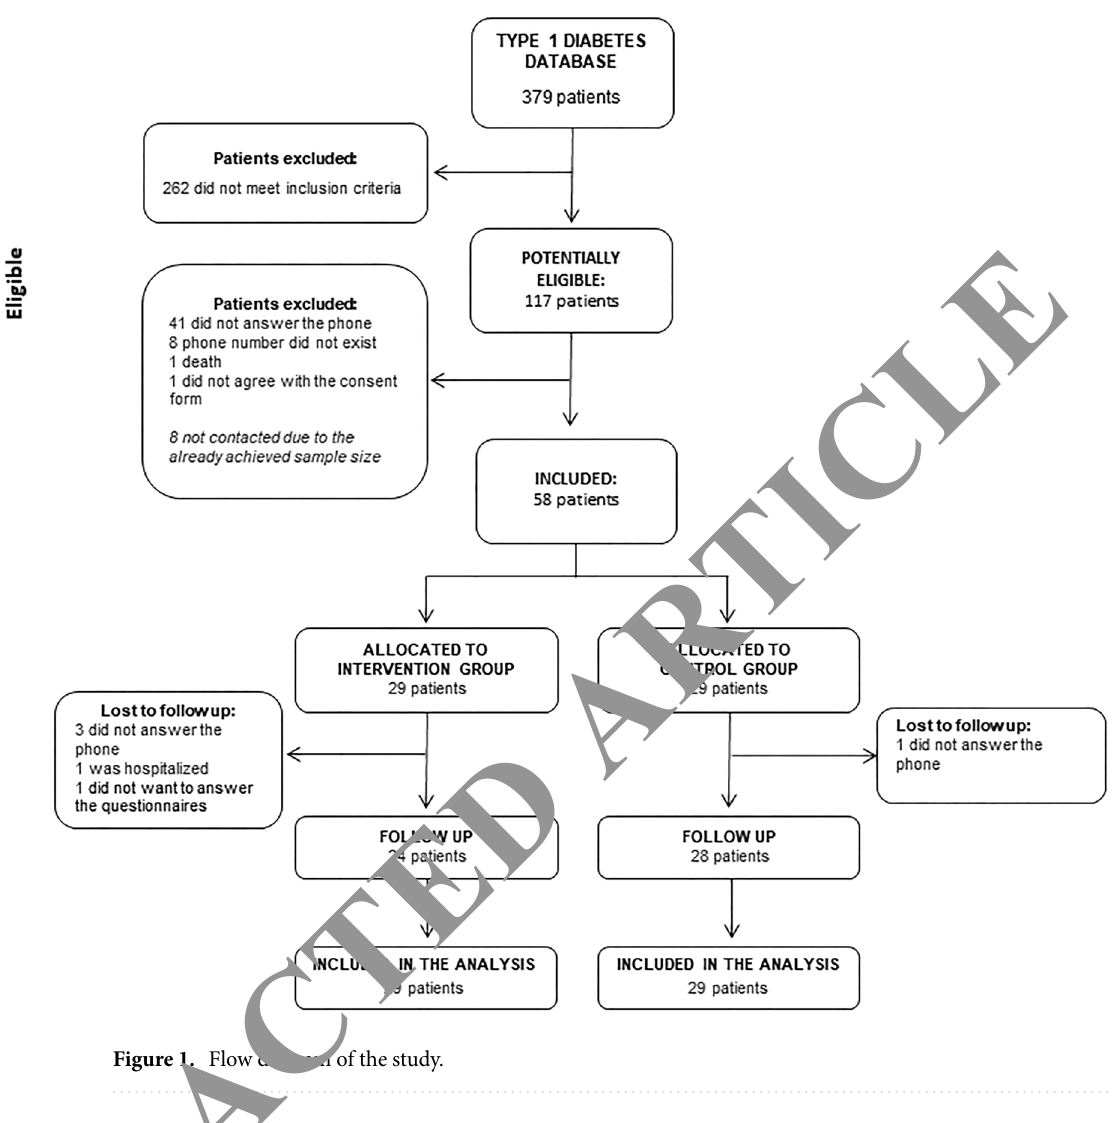
Figure 1. Flow diagram of the